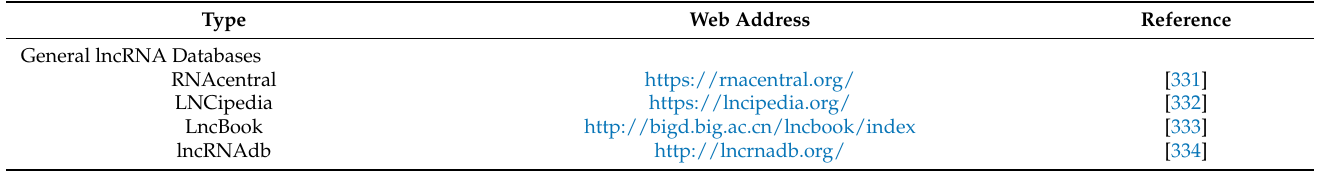
Table 4. A short overview of online resources useful for lncRNA research in cancer.